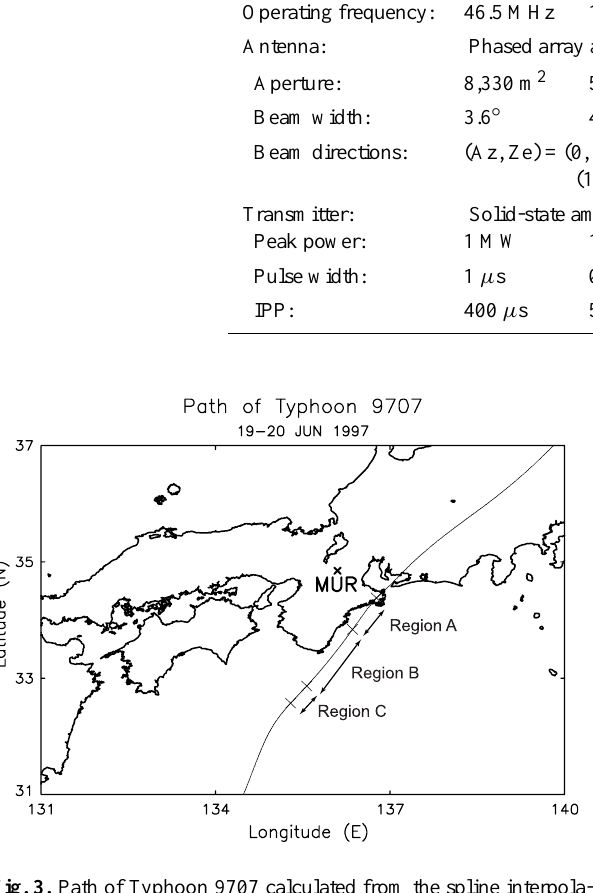
Fig. 3. Path of Typhoon 9707 calculated from the spline interpola- tion applied with the locations reported by JMA. A cross sign ( × ) indicates the location of the MU